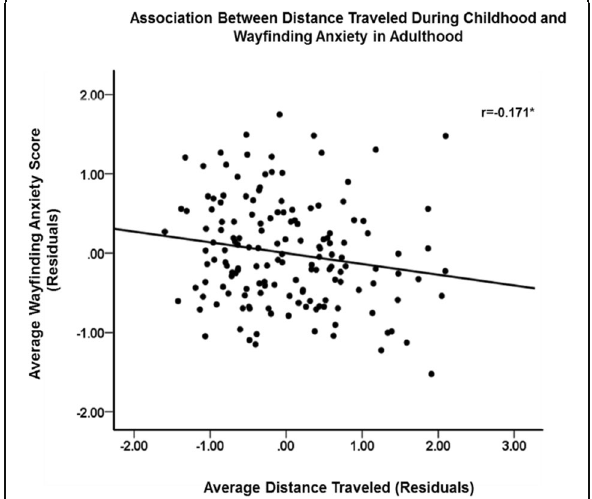
Fig. 7 Individual differences in the relationship between distance traveled and wayfinding anxiety, controlling for participant sex and trait anxiety. * p <